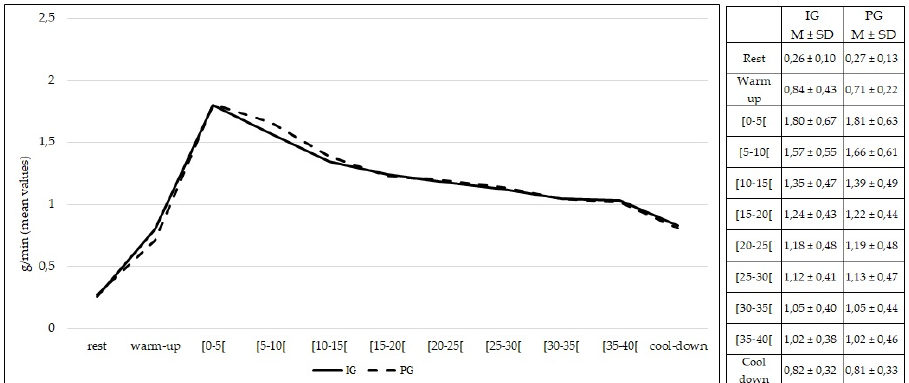
Figure 7. Carbohydrate oxidation during rest, exercise, and cool-down in intervention group and placebo group. Data are expressed as mean ± standard deviation. IG: intervention group; PG: placebo group.